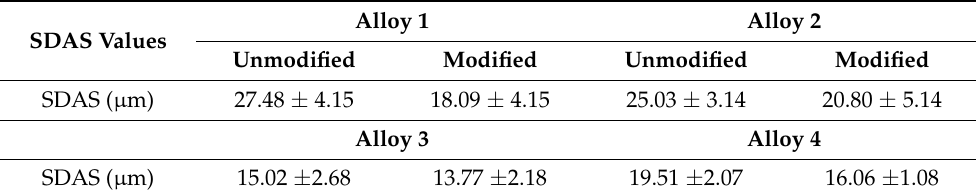
Table 3. SDAS values measured.